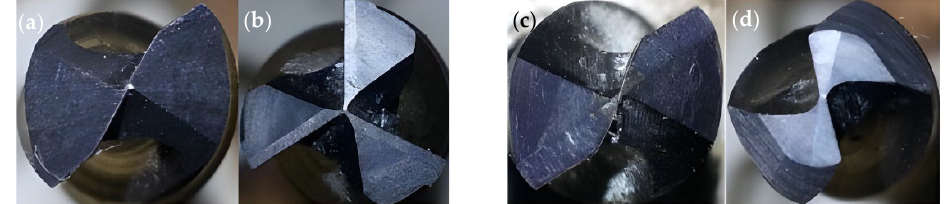
Figure 16. Drill point geometry: ( a ) 2-fluted, ( b ) 3-fluted, ( c ) 4-faceted and ( d ) 8-faceted [169].